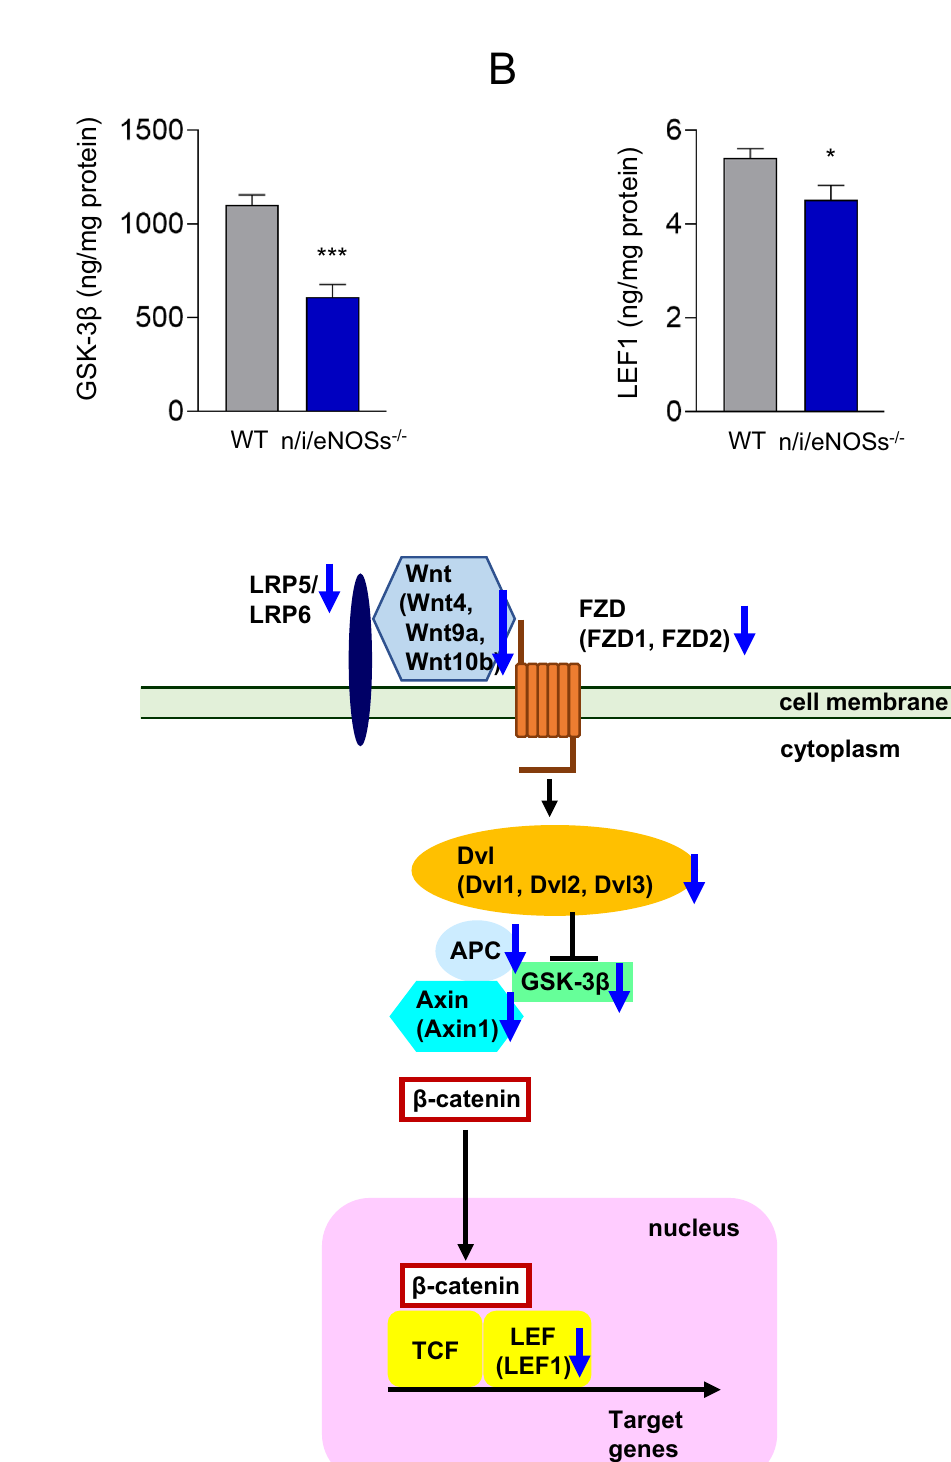
Figure 5. Lung GSK-3β and LEF1 protein expression levels and a schematic diagram showing the down- regulation of the Wnt ligands and Wnt/β-catenin signaling components in the lung of triple n/i/eNOSs −/− mice. (A) GSK-3β protein expression levels in the lung (n = 9–10), *** P < 0.001. (B) LEF1 protein expression levels in the lung (n = 9–10), * P < 0.05. (C) A schematic diagram showing the down-regulation of the Wnt ligands and Wnt/β-catenin signaling components in the lung of triple n/i/eNOSs −/− mice. Blue down arrows indicate the down-regulation. LRP lipoprotein receptor-related proteins, FZD frizzled, Dvl disheveled, APC adenomatous polyposis, GSK-3β glycogen synthase kinase-3β, TCF T cell factor, LEF lymphoid enhancer-binding